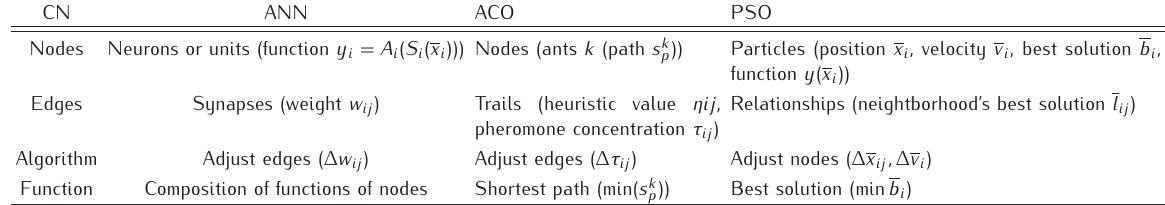
Table 1. Particular instantiations of CNs: ANN, ACO, and PSO.